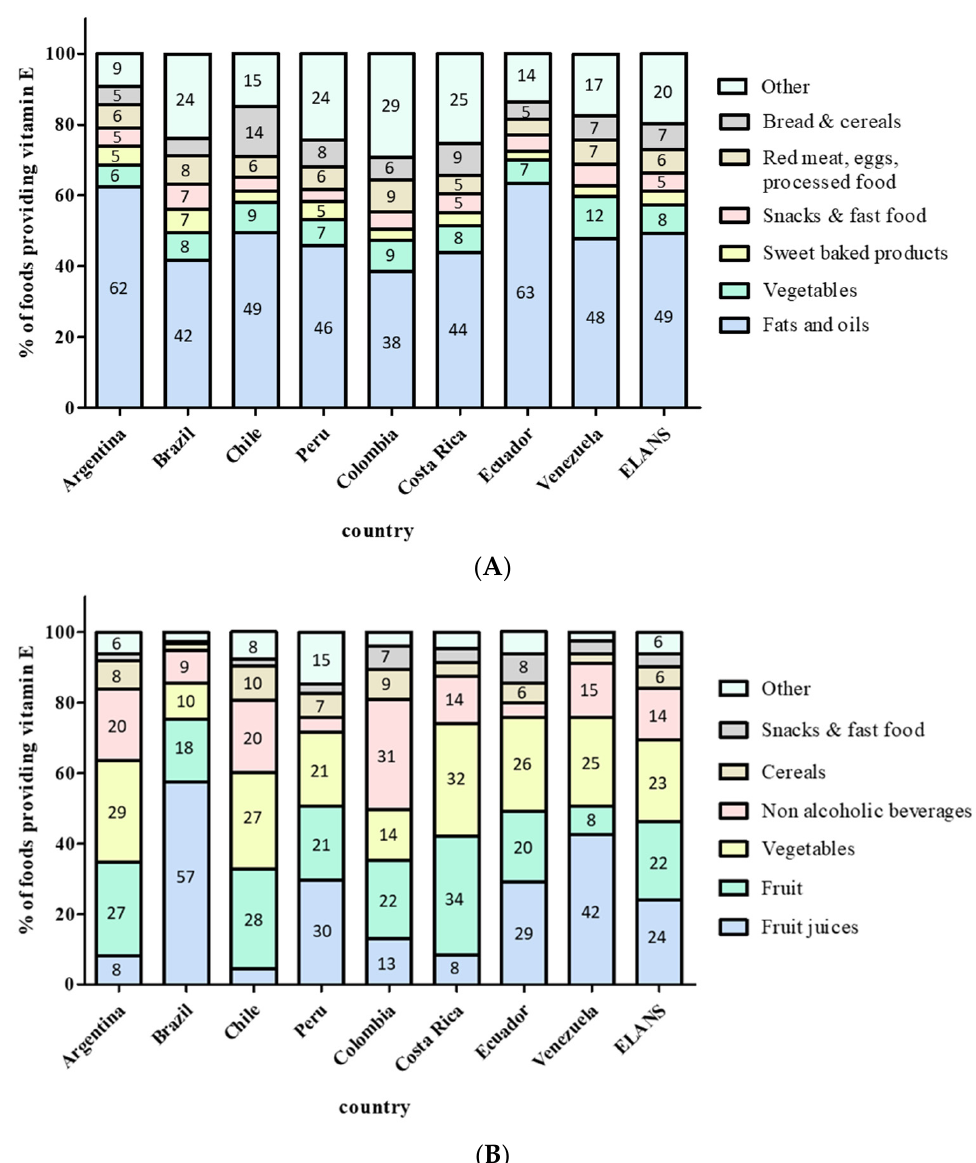
Figure 2. Dietary contributions of food sources to vitamin E ( A ) and vitamin C ( B ) intakes in LatAm WRA participating in ELANS.